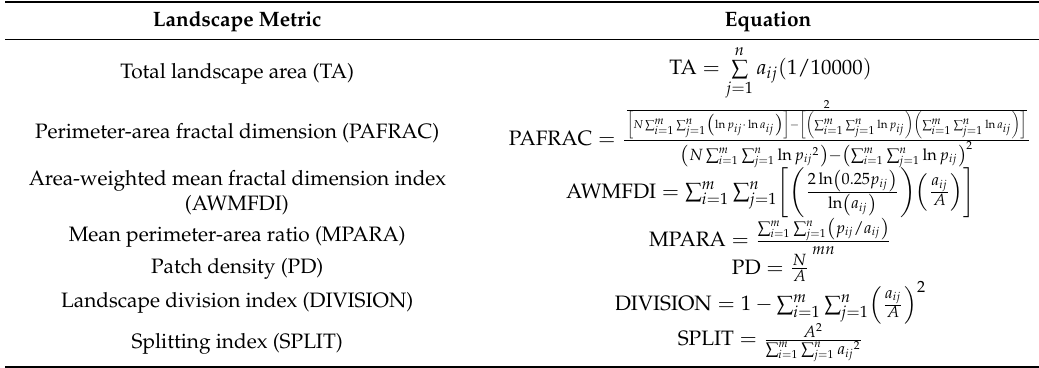
Table 3. Description of landscape metrics used in the